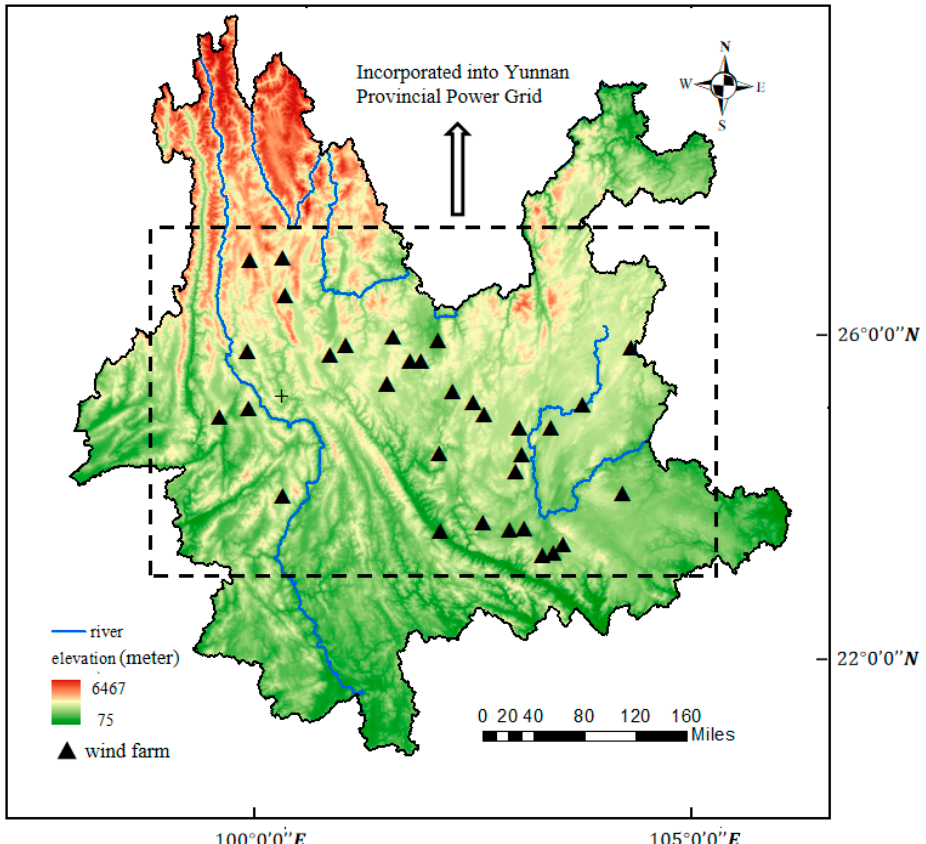
Figure 1. Distribution map of wind farm and terrain in Yunnan Province, China.